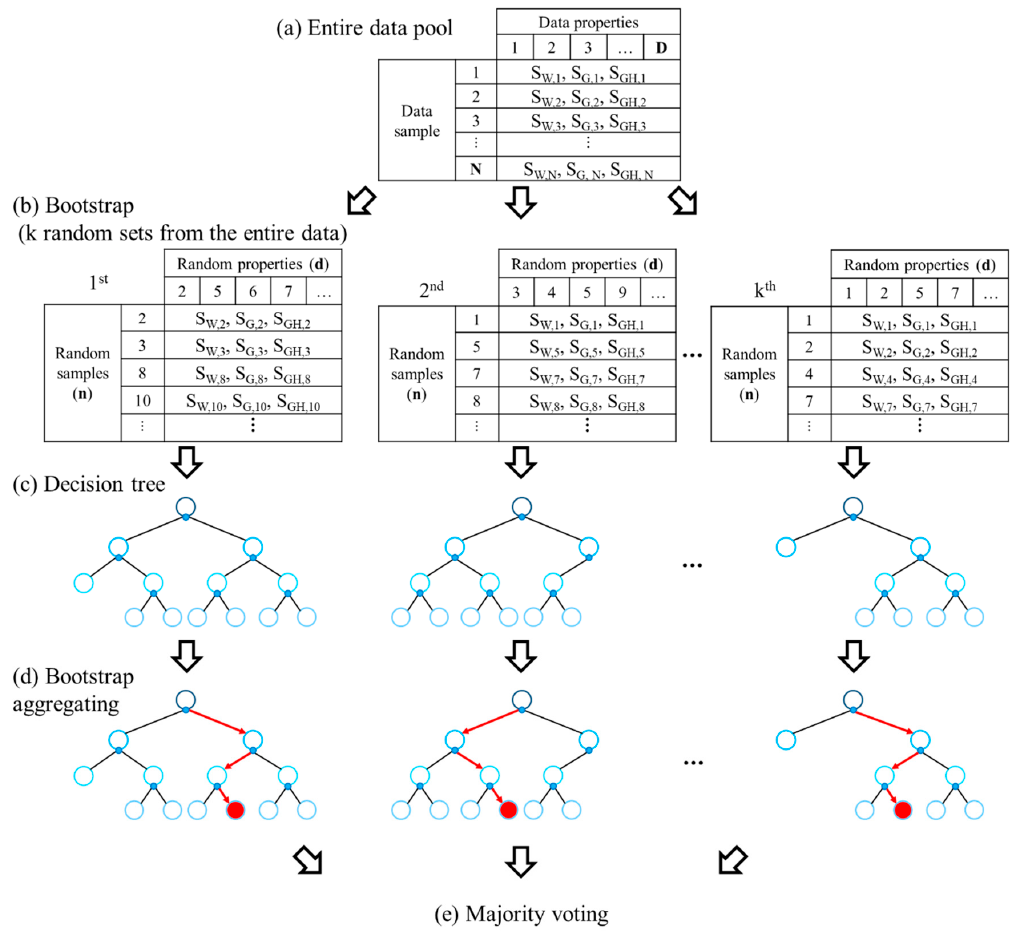
Figure 5. Random forest with multiple decision trees for the prediction of the target parameters [16]. ( a ) The whole data with properties of D and data sample of N; ( b ) random data choice to construct data groups of k; ( c ) generation of k multiple trees from each of data groups; ( d ) summation of decisions according to multiple trees; ( e ) final decision making for given input.